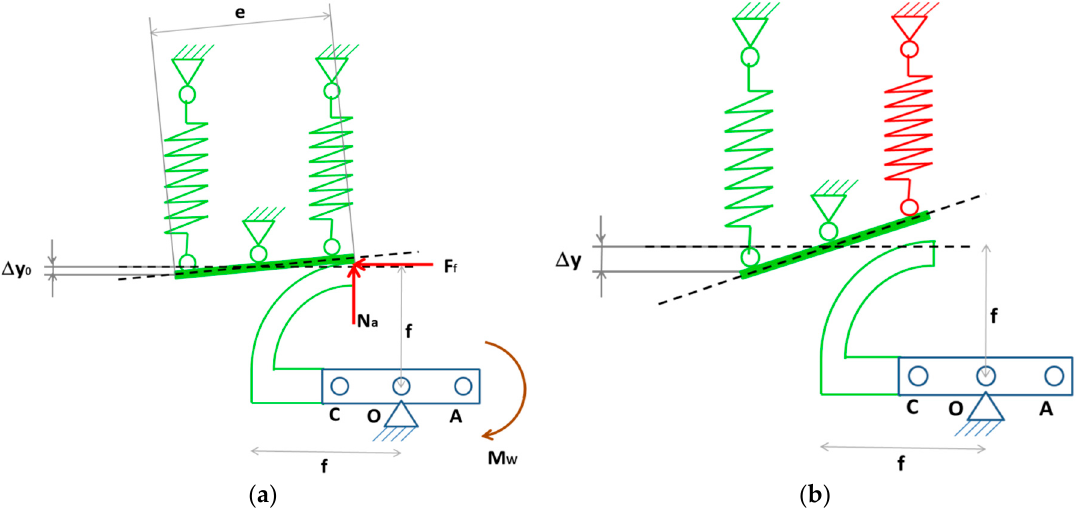
Figure 8. Locking subsystem structural scheme: locking condition ( a ); unlocking condition ( b ). The points O, A and C represent the landing gear arm pivot and the bottom hinges of the SMA springs used to deploy the arm (see Figure 3); Δ y 0 and Δ y indicate the initial and final vertical displacements of the left spring, with respect to the pivot of the friction element (green bold line); the quote e indicates the extension of this element, whose minimum distance with respect to the pivot O (contact with the circular slide) is equal to f ; finally, N a , F f and M w indicate the normal contact reaction, the corresponding tangential friction and the moment of the weight of the arm with respect to the pivot O.